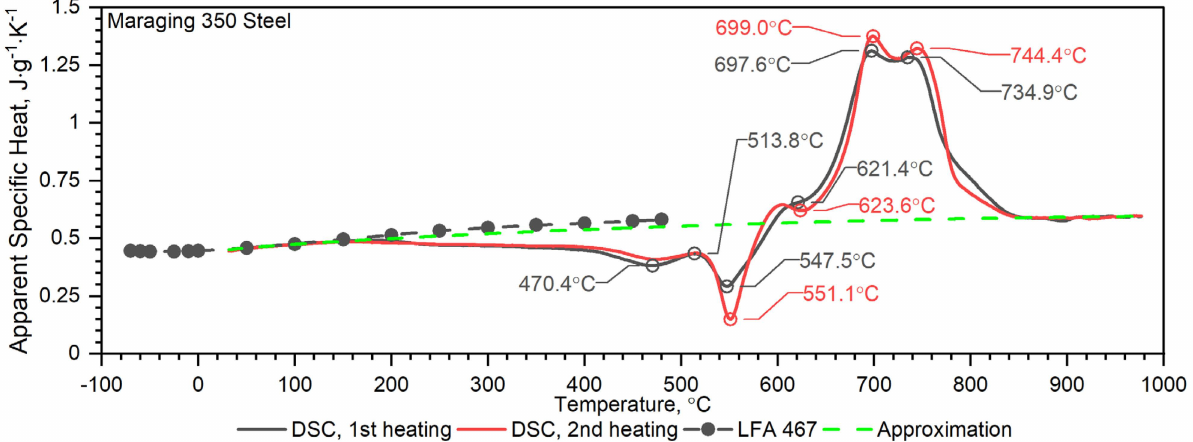
Figure 15. Temperature characteristics of apparent specific heat for the Maraging 350 steel obtained from the first and second heating run: dashed black line—results obtained from LFA 467; dashed green line—approximation of measurement on